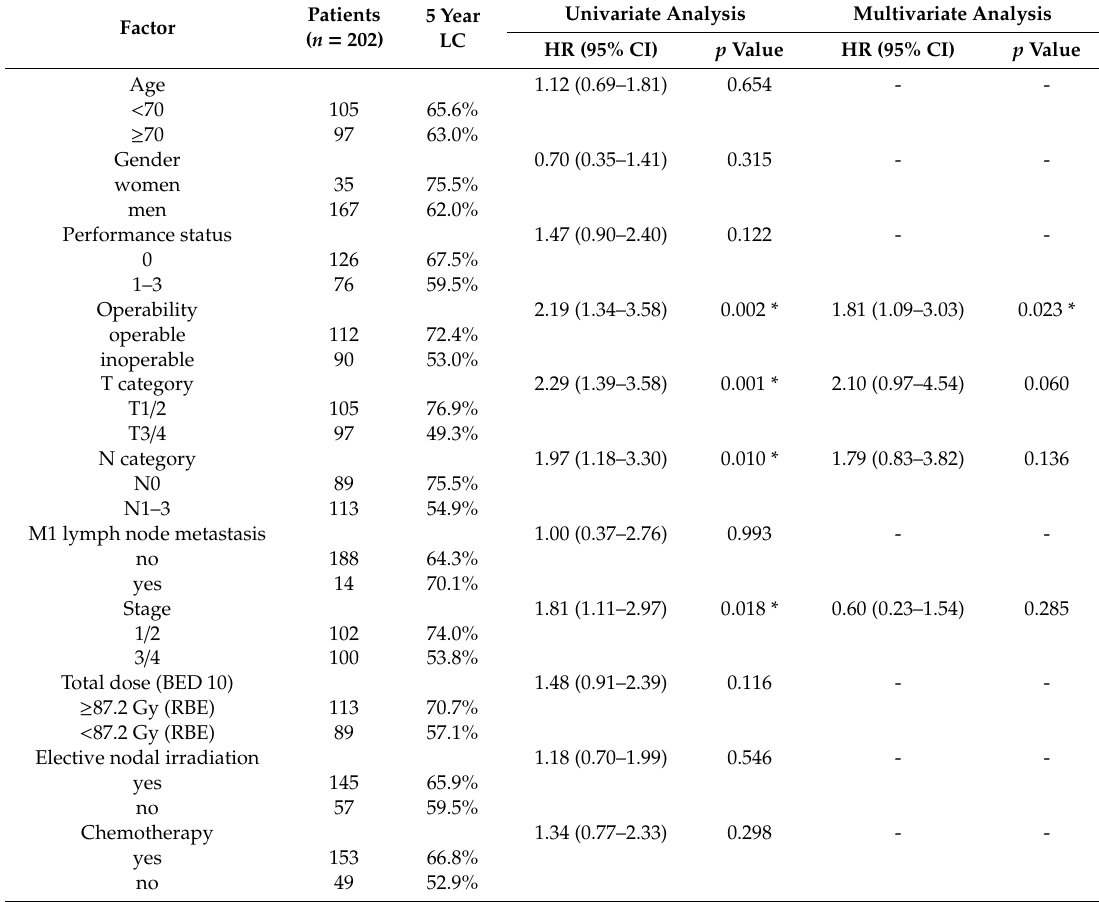
Figure 2. Local control rate. Table 3. Univariate and multivariate analysis for local